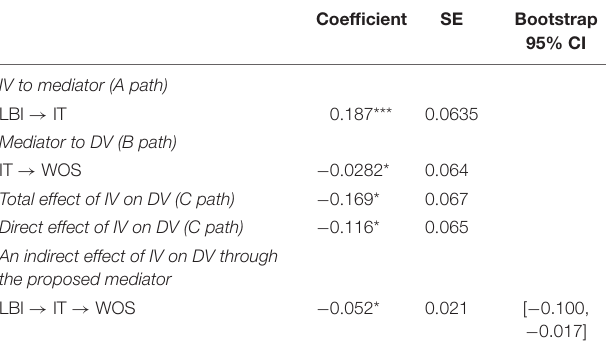
TABLE 3 | Results of the mediation